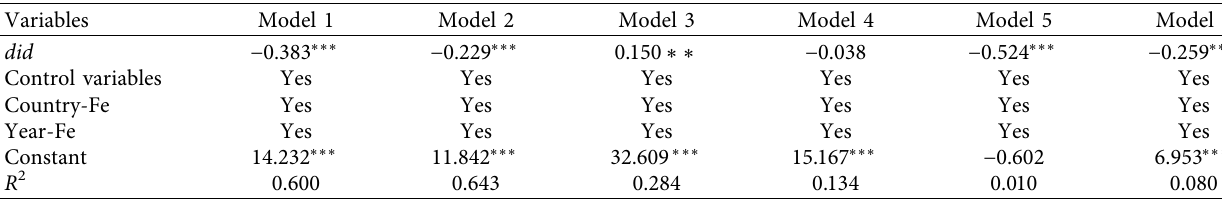
Table 8: Heterogeneity analysis results.